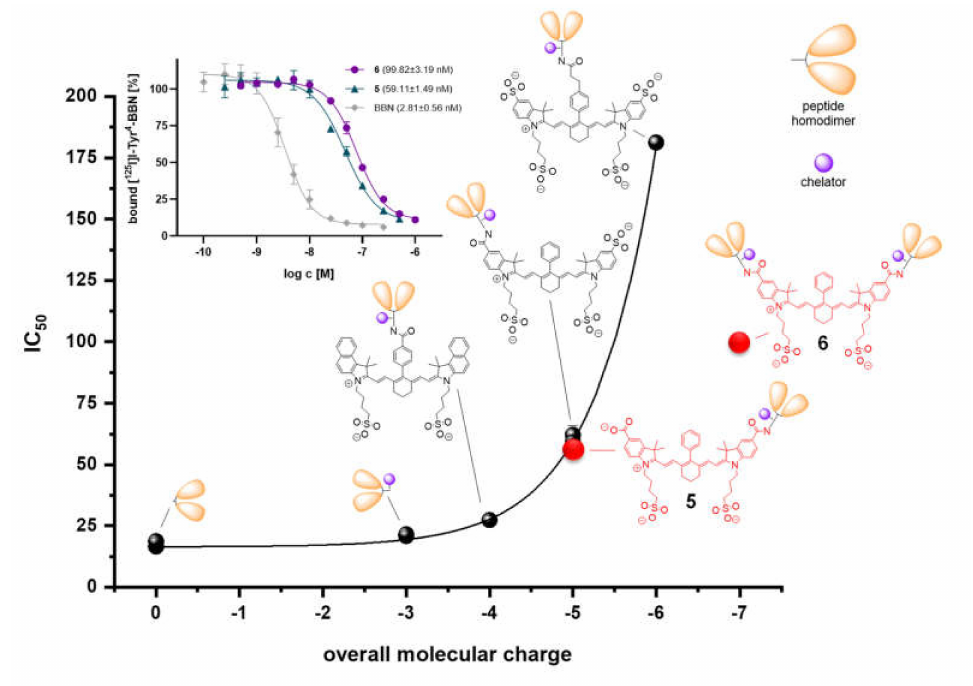
Figure 3. Depiction of the results of the competitive displacements assays on GRPR-transfected HEK- 293 cells for in vitro determination of GRPR affinities of the new hybrid multimodal imaging agents 5 and 6 . Graphical classification of the new data (red data points and structures) in the context of the literature values (black data points and structures). Shown is the correlation between IC 50 values and overall molecular charge of the MIU-derivatized PESIN dimers (black data points and 5 ) and tetramer ( 6 ). Insert: binding curves, giving IC 50 values of 2.8 ± 0.6 nM for bombesin, 59.1 ± 1.5 nM for 5 and 99.8 ± 3.2 nM for 6 . Results were obtained from at least three different experiments, each performed in